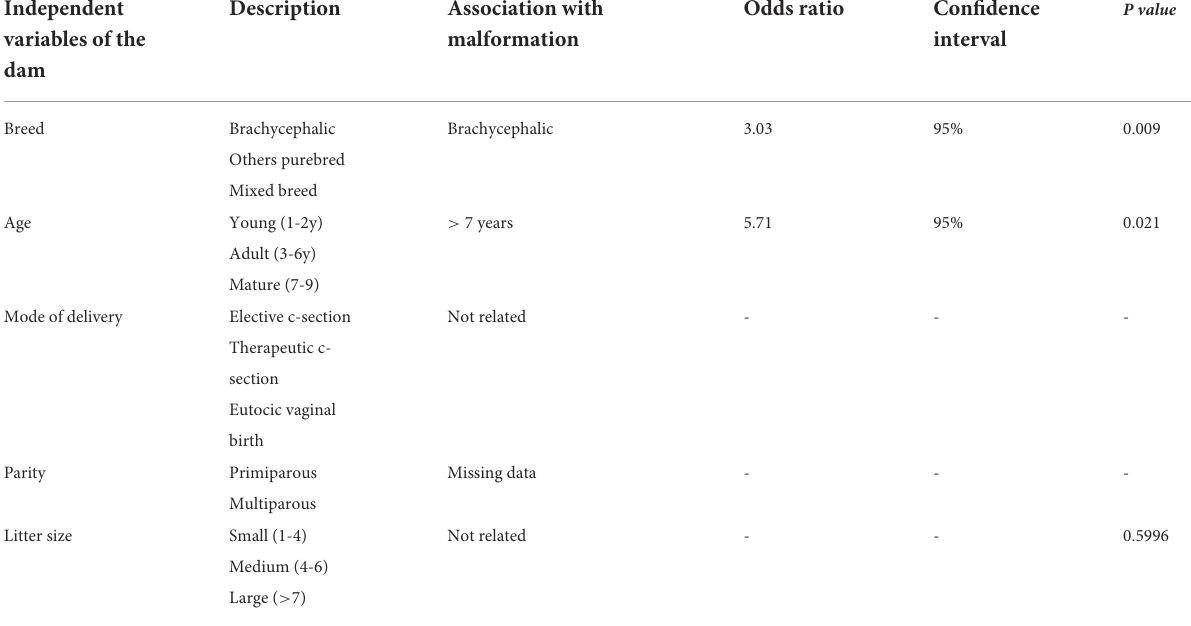
TABLE 4 Odds ratio, confidence interval, and significance according to independent variables of the dam.